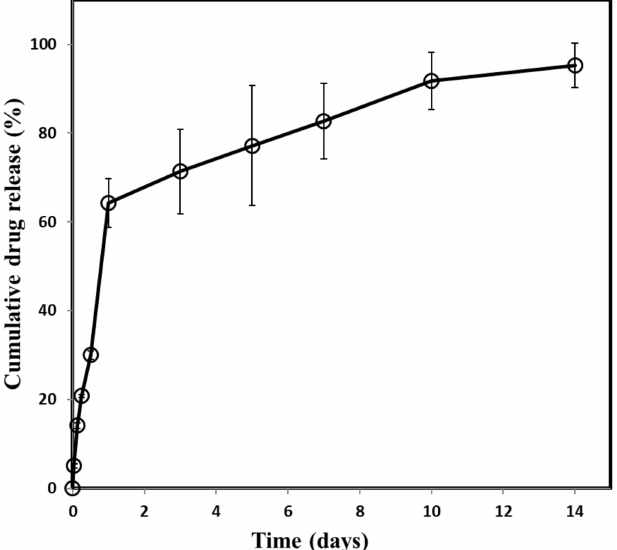
Figure 5. In vitro release profiles of tranilast from the PC/Tr/I. Error bars are the standard